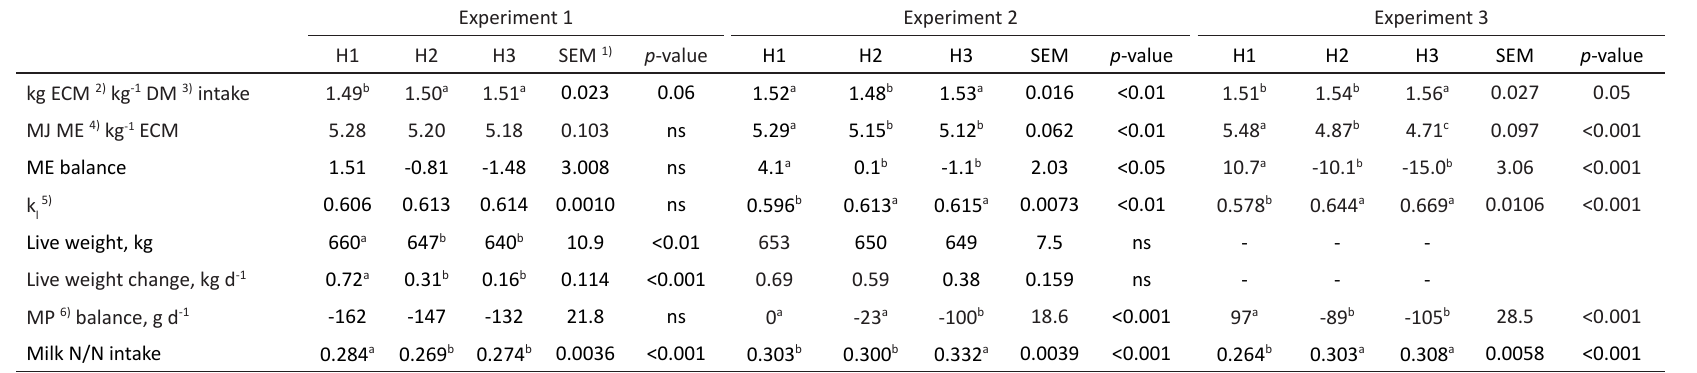
Table 6. Efficiency of milk production of dairy cows fed first (H1), second (H2) and third cut (H3) grass silages across different years. Experiment 1 Experiment